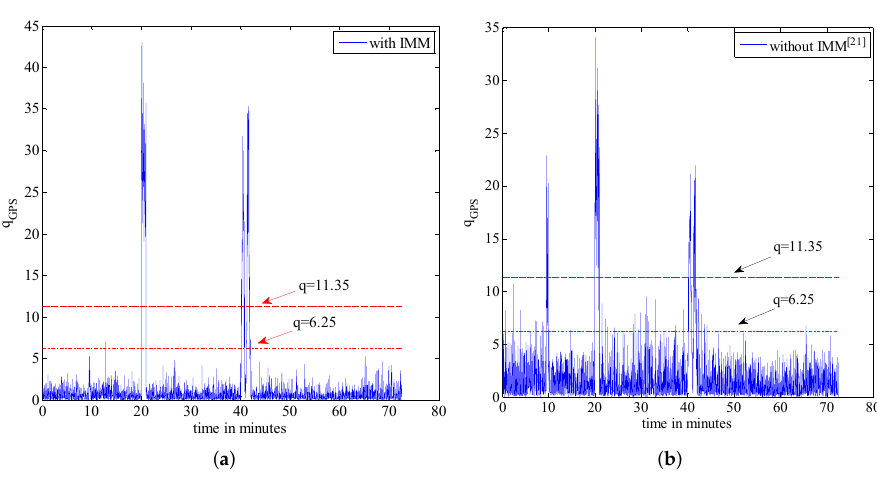
Figure 11. Failure detection curve. ( a ) Algorithm with IMM; ( b ) Algorithm without IMM